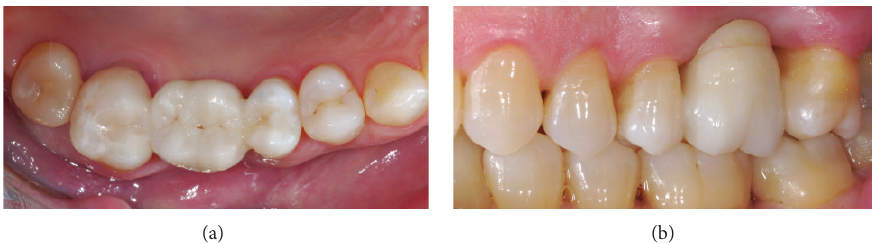
Figure 10: (a) Occlusal view of the luted IRFDP just after rubber dam removal. (b) Lateral view of the rehabilitation: function and esthetic were